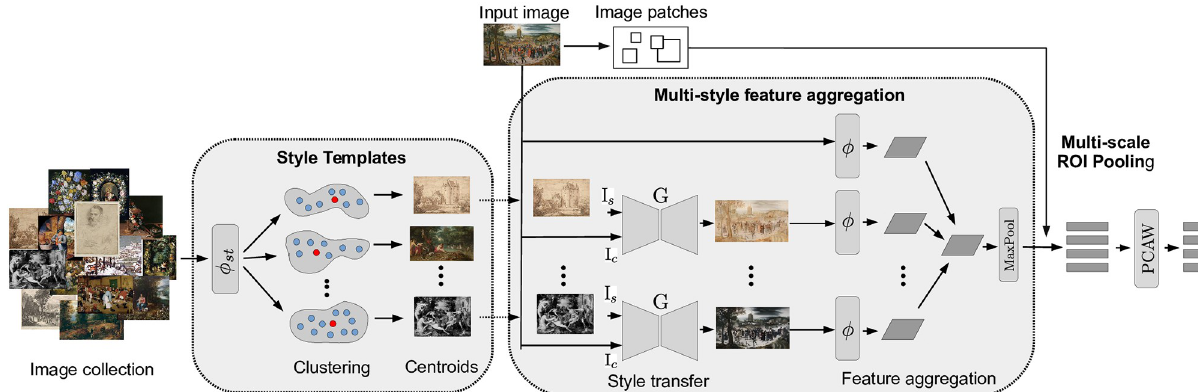
Fig 4. Overview of the multi-style feature aggregation. It consists of three main parts: First, we extract the features of all images using a style classification network, cluster them in the feature space, and select the cluster centers as style templates. Second, given an input image, it is stylized concerning all style templates using a universal style transfer model. Then, all stylized image features are extracted and aggregated to the final multi- style feature representation. Third, given the feature map of this representation and a set of image patches, their feature descriptors are extracted using multi-scale ROI pooling. Please see the text for more details. Image material is shared by Wikimedia Commons [5] either as public domain or under a CC0 license.